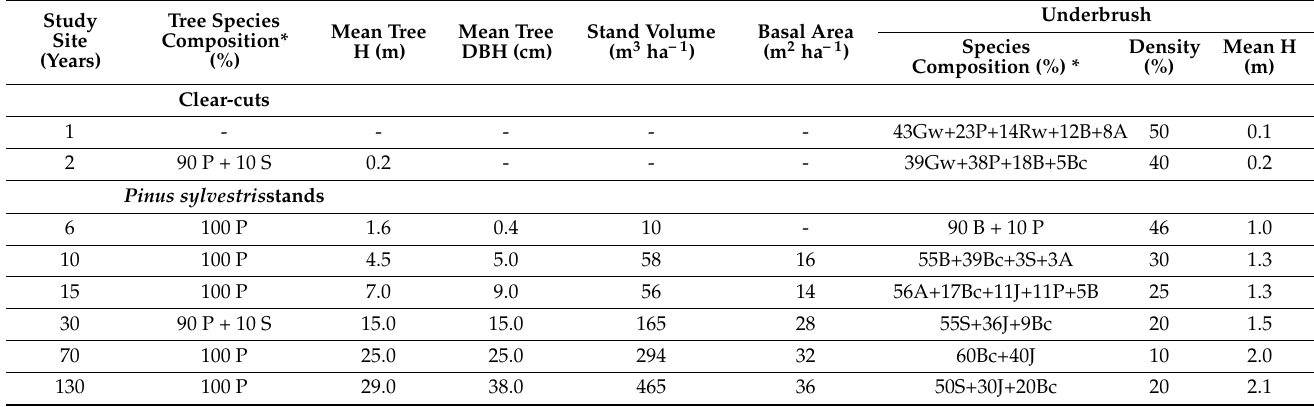
Table 7. Characteristics of the P. sylvestris L. forests (Mean tree height (H), DBH, basal area, and characteristics of underbrush were measured during this survey according to Ref. [58]; stand volume data were obtained from the Lithuanian State Forest Cadastre database